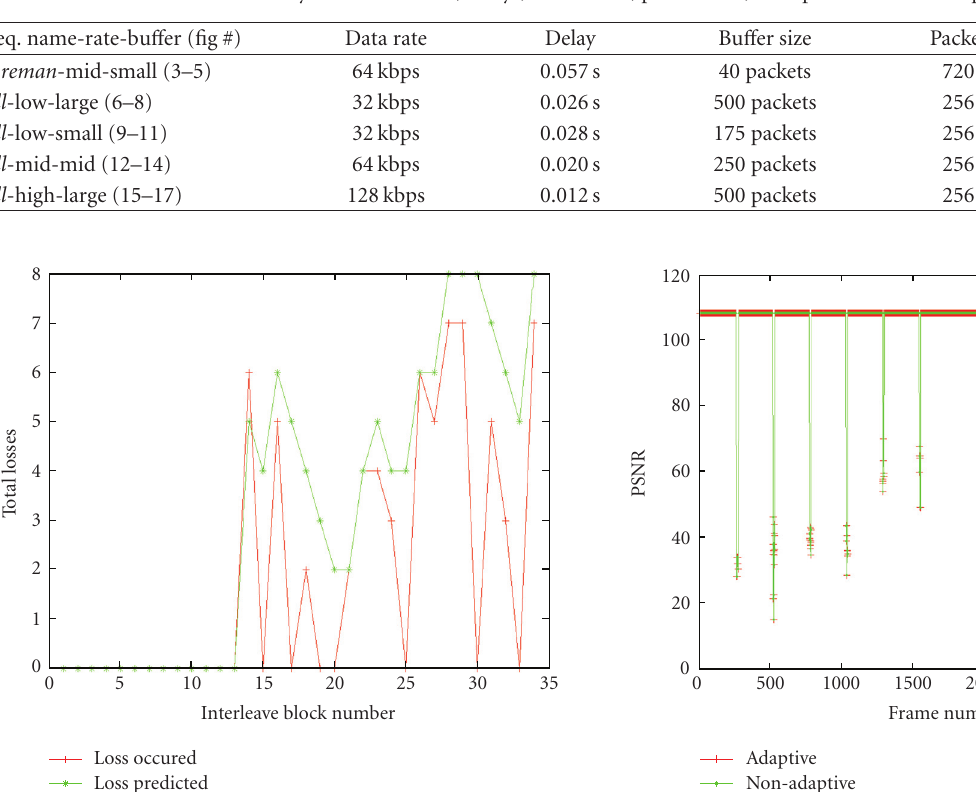
Table 1: Summary of the data rates, delays, bu ff er sizes, packet sizes, and span sizes for the experiments.